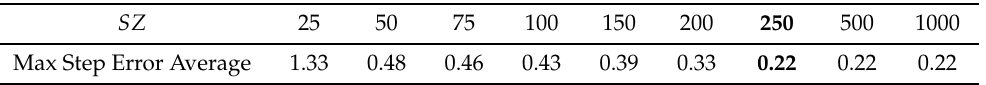
Table 1. Finding SZ for best polynomial match. Selected values are shown in